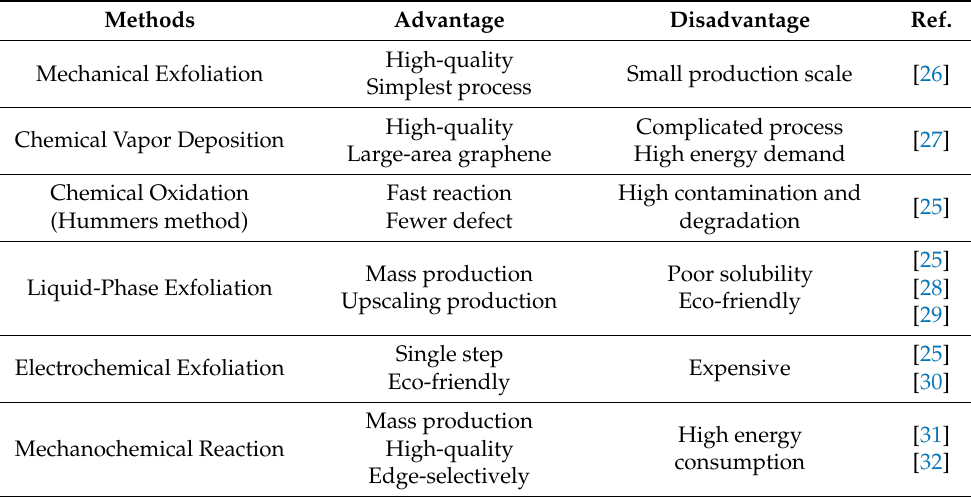
Table 1. Advantages and disadvantages of the graphene preparation method. Methods Advantage Disadvantage